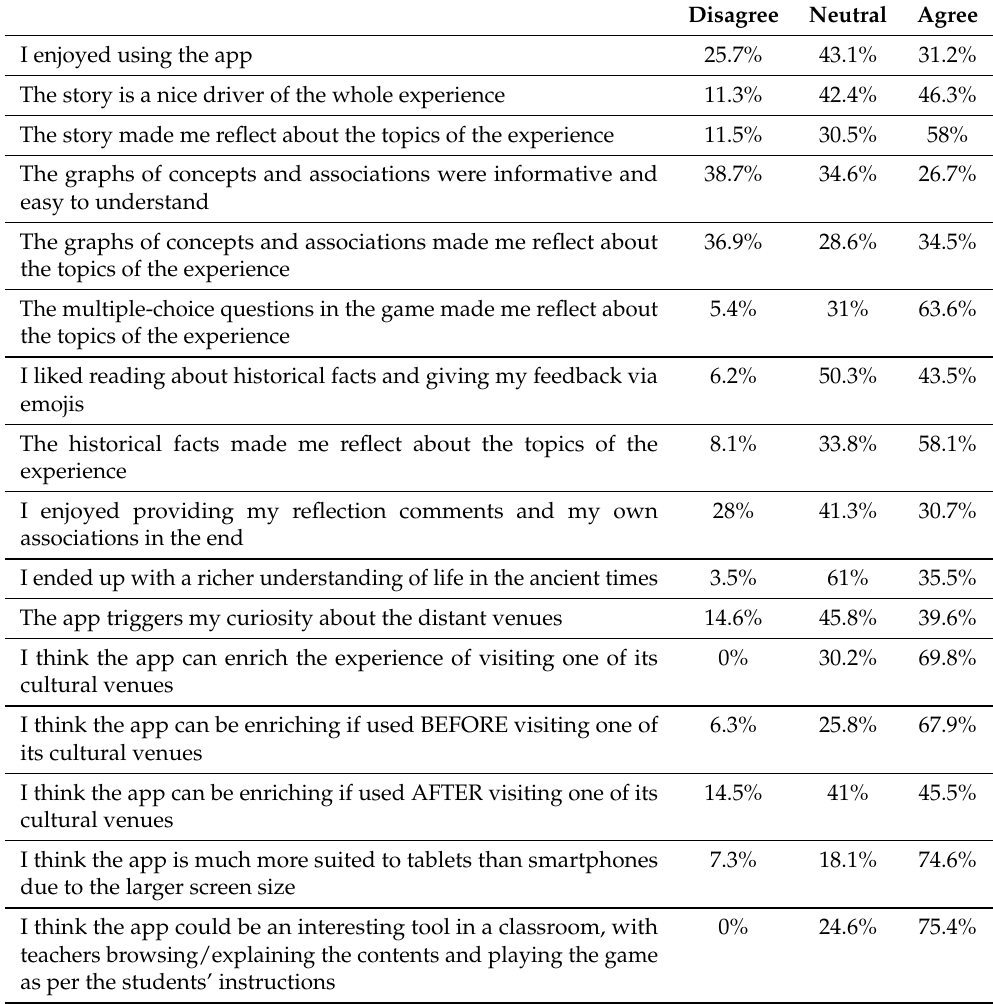
Table 1. Summary of replies to the main questions about the mobile